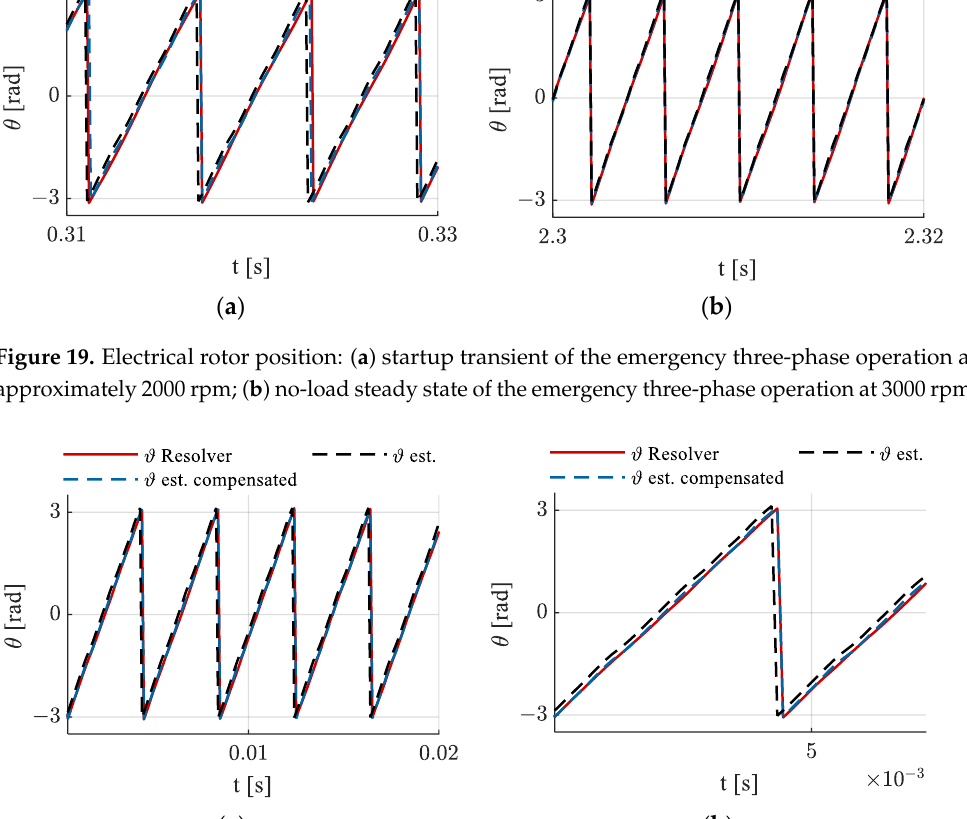
Table 1. Machine parameters.